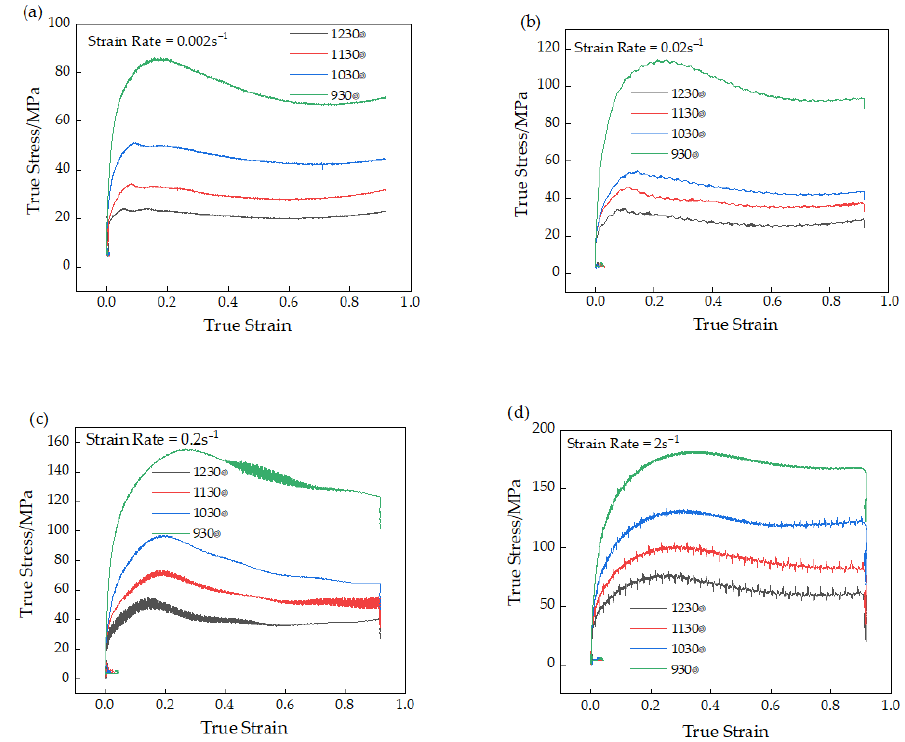
Figure 2. Stress-strain curves of 20MnCr5(SH) gear steel at different strains with temperature of ( a ) 0.002 s − 1 ; ( b ) 0.02 s − 1 ; ( c ) 0.2 s − 1 ; ( d ) 2 s − 1 .